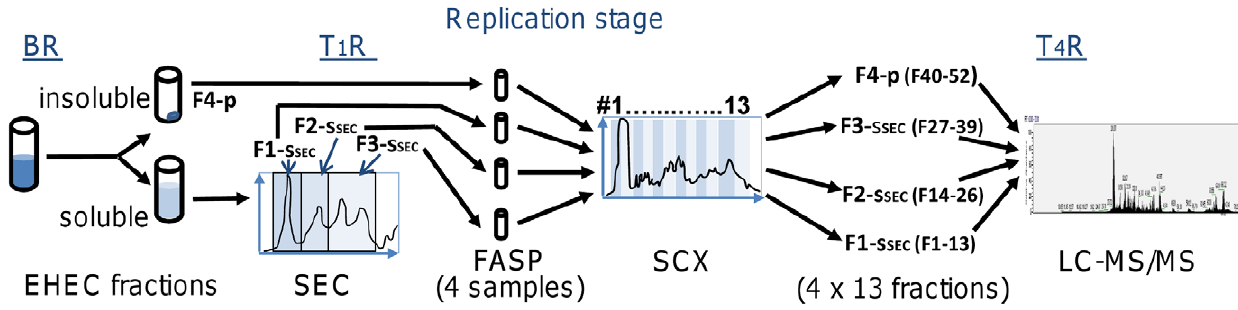
Figure 1. Experimental design combining two-dimensional LC-MS/MS with upfront fractionation of proteins derived from insoluble and soluble, SEC-separated cell lysate fractions. Abbreviations: EHEC, enterohemorrhagic E. coli ; SEC, size exclusion chromatography; FASP, filter-aided sample preparation for digestion of complex protein mixtures; SCX, strong cation exchange chromatography; BR, biological replicate; T 1 R and T 4 R, technical replicate stages. The total number of SCX fractions subjected to LC-MS/MS sequentially was 52 in a given experiment.